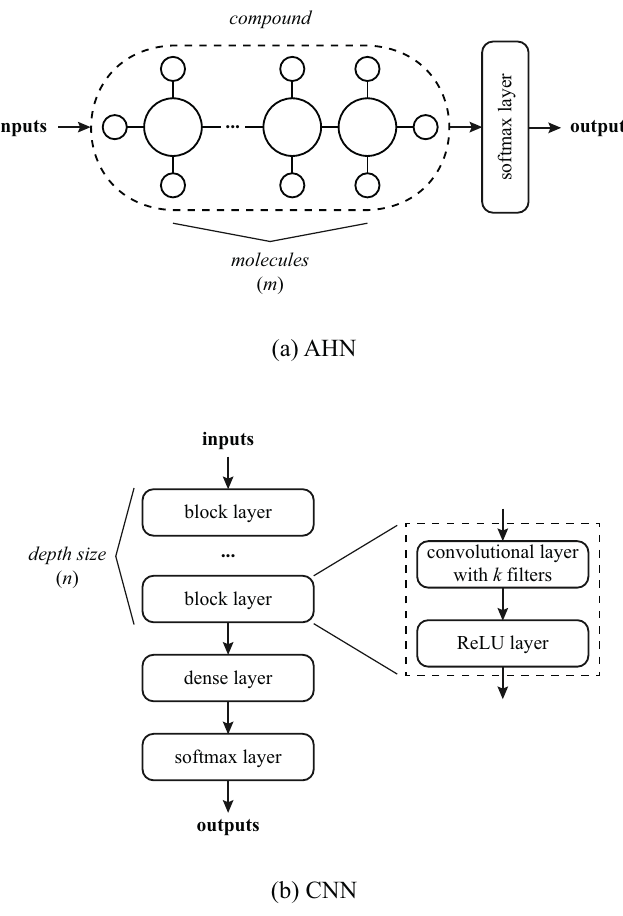
Figure 7. Architecture prototypes of the models: ( a ) AHN and ( b )